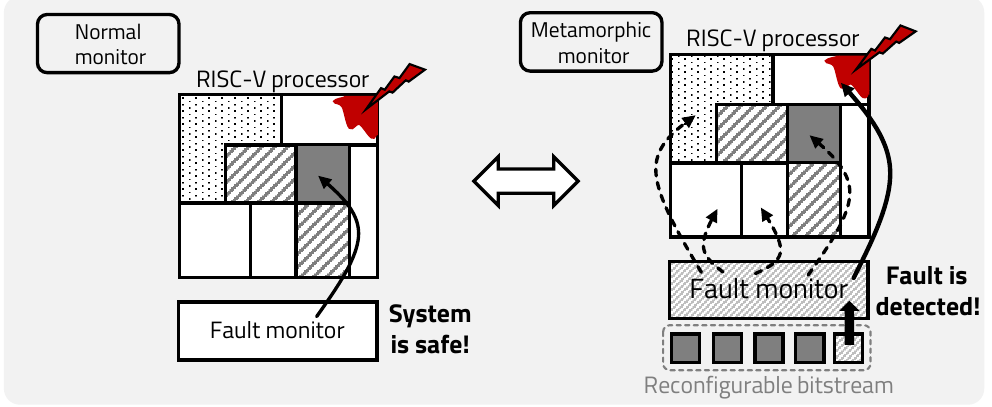
Figure 9. The need for metamorphic monitoring.